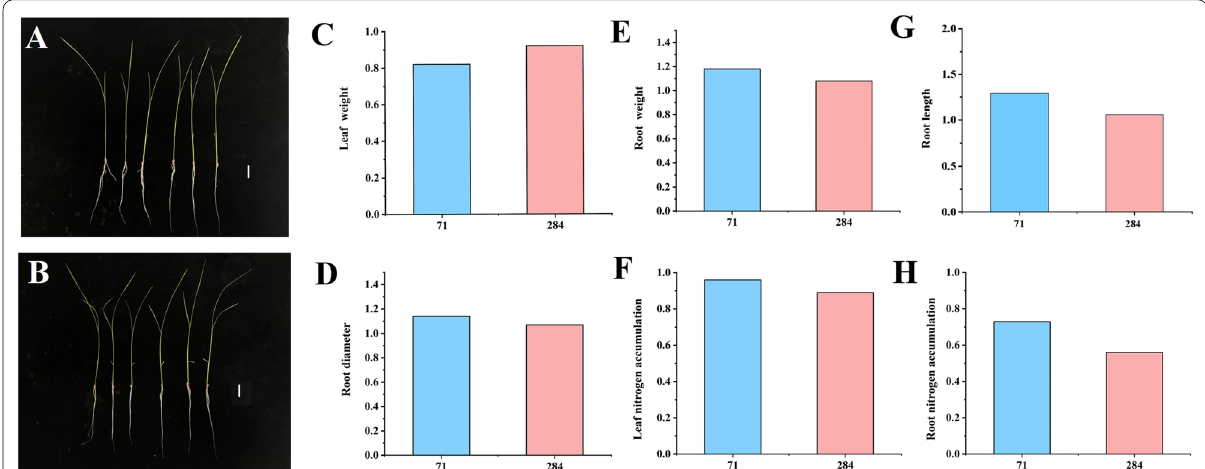
Fig. 10 Root morphology traits of low-nitrogen tolerant variety (Longjing 31) and low-nitrogen sensitive variety (Songjing 10) under low and high nitrogen treatments. A The seedling of Longjing 31 under high (three on the left) and low (three on the right) nitrogen treatments. B The seedling of Songjing 10 under high (three on the left) and low (three on the right) nitrogen treatments. Scale bar represented 2 cm. C The relative value of the leaf weight under low and high nitrogen treatments. D The relative value of the root diameter under low and high nitrogen treatments. E The relative value of the root weight under low and high nitrogen treatments. F The relative value of the leaf nitrogen accumulation under low and high nitrogen treatments. G The relative value of the root length under low and high nitrogen treatments. H The relative value of the root nitrogen accumulation under low and high nitrogen treatments. 71: Longjing 31. 284: Songjing